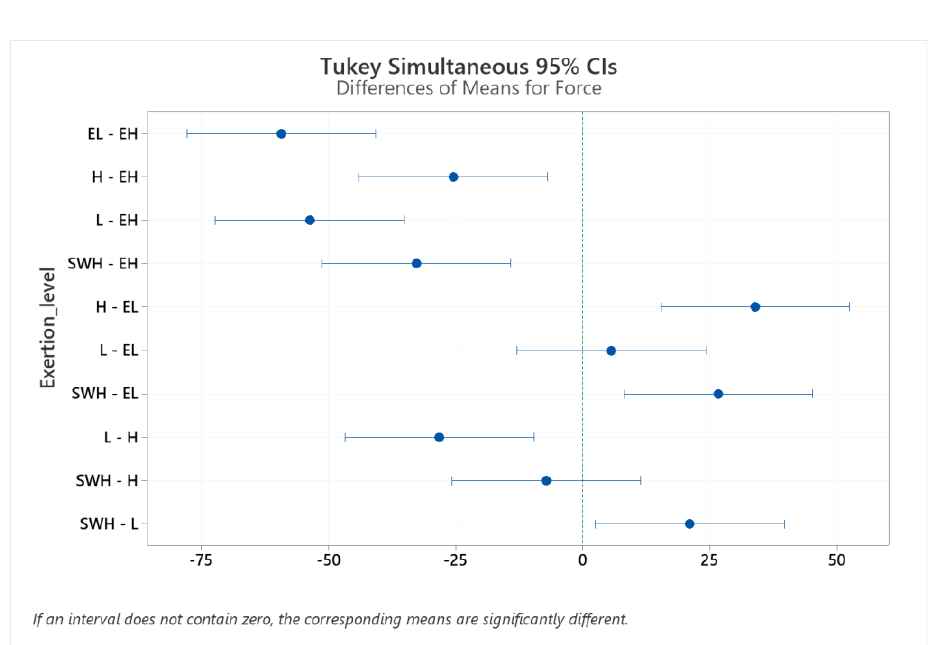
Figure 6. Pairwise comparison between isometric forces at different levels of physical exertion to extremely light (EL), light (L), somewhat hard (SWH), hard (H), and extremely hard (EH). CI: confidence interval.